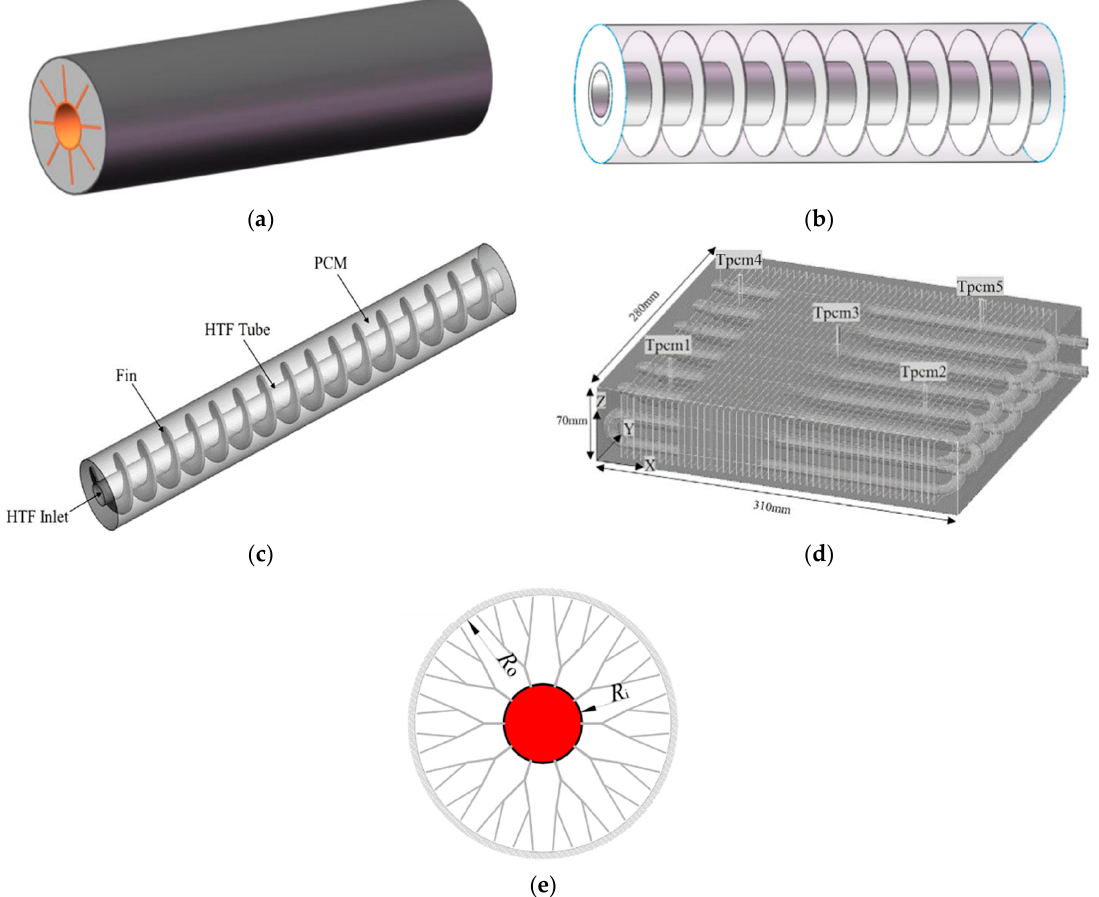
Figure 2. Different shapes of fin structure in LHTES devices. ( a ) Rectangular fins [3]; ( b ) Annular fins [4]; ( c ) Spiral fins [5]; ( d ) Plate fins [6]; ( e ) Dendritic fins [7]. (Permission to reproduce from Refs.